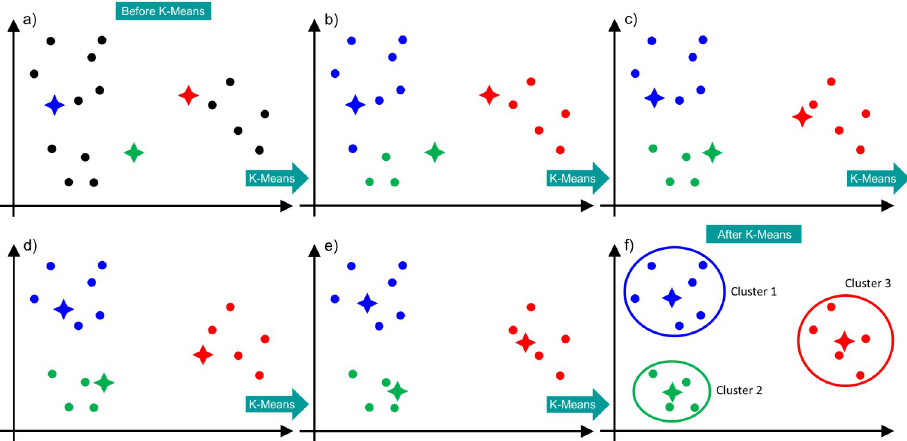
Fig 5. Schematic visualization of the work of the K-means algorithm. The data is in black. The stars mark the centroids. The clusters are represented by the colors blue, green and red.